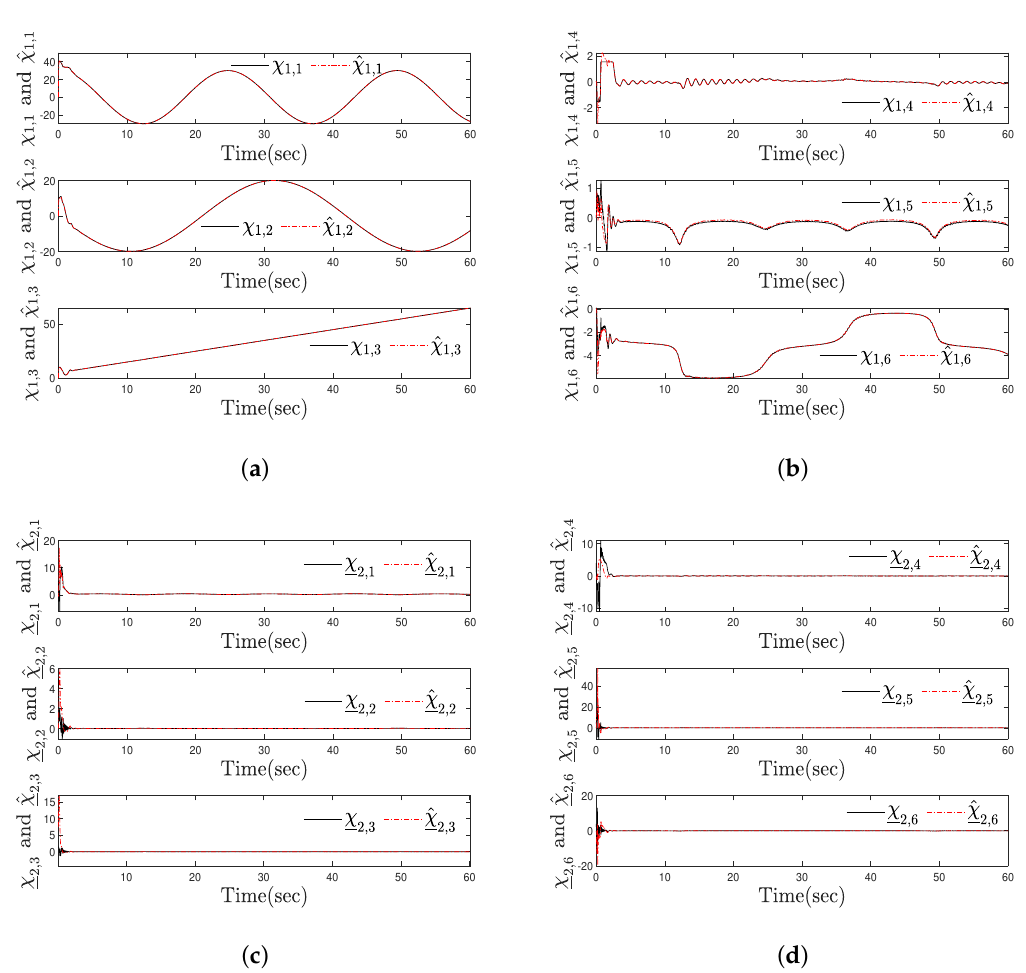
Figure 16. State estimation results of the proposed approach for Scenario 3 ( a ) χ 1,1 , ˆ χ 1,1 , χ 1,2 , ˆ χ 1,2 , χ 1,3 and ˆ χ 1,3 ( b ) χ 1,4 , ˆ χ 1,4 , χ 1,5 , ˆ χ 1,5 , χ 1,6 and ˆ χ 1,6 ( c ) χ 2,1 , ˆ χ 2,1 , χ 2,2 , ˆ χ 2,2 , χ 2,3 and ˆ χ 2,3 ( d ) χ 2,4 , ˆ χ 2,4 , χ 2,5 , ˆ χ 2,5 , χ 2,6 and ˆ χ 2,6 .